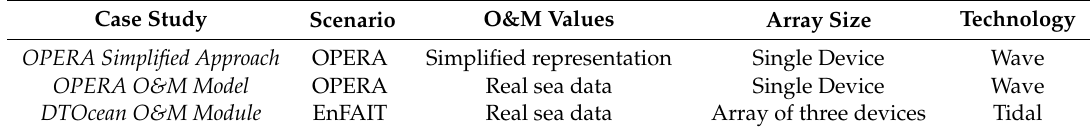
Table 1. The three case studies and the difference in their considerations.